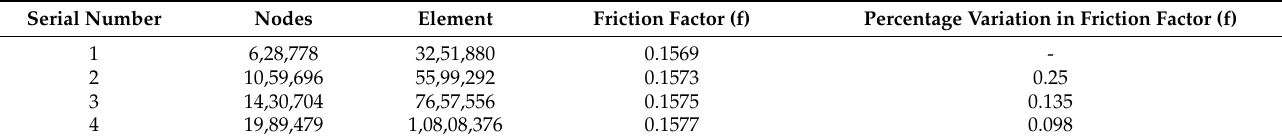
Table 3. Boundary Conditions.